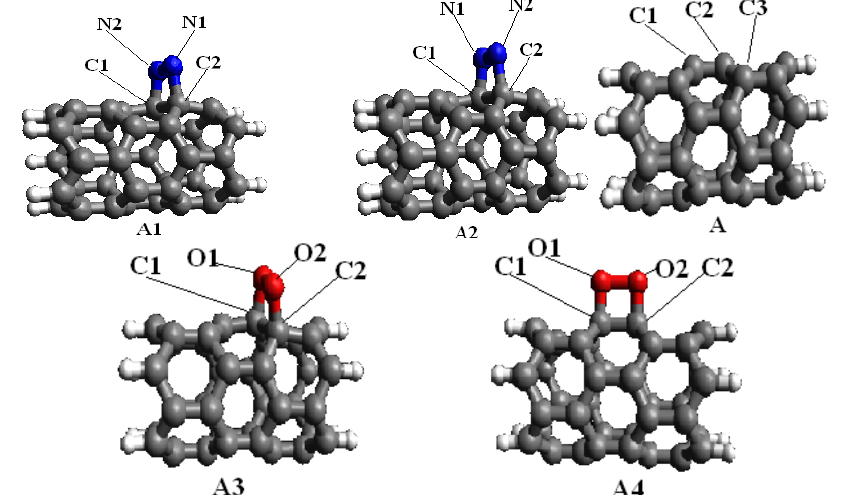
Figure 1. (A) The(5,0)SWCNT,( A (sitesA and A ,respectively) ( A 1 2